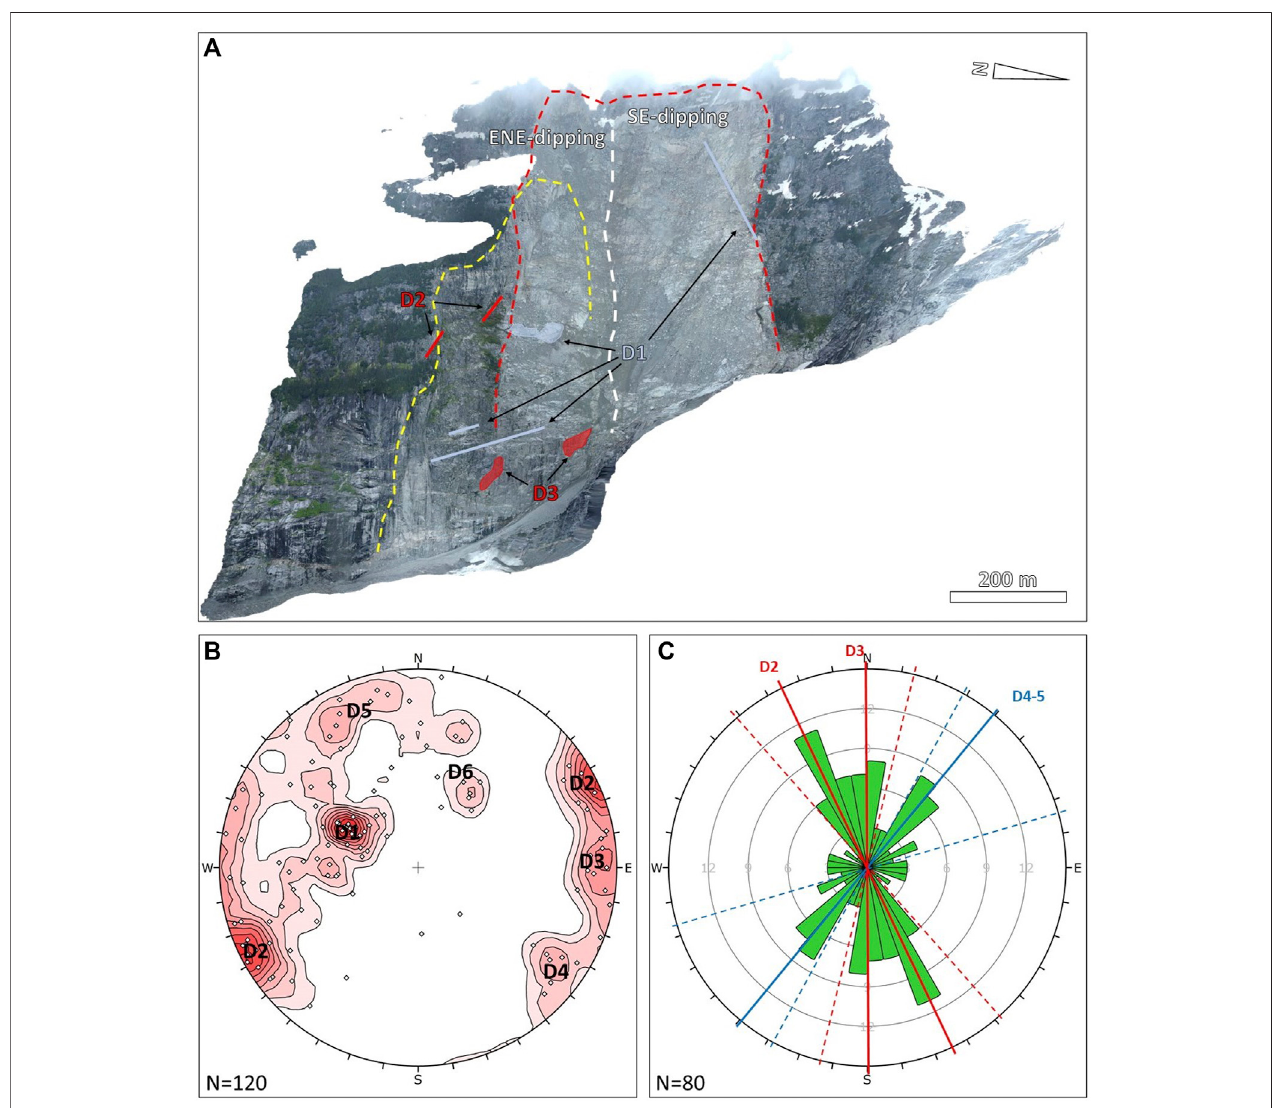
FIGURE 7 | Summary of the rock mass discontinuity mapping results. (A) orthorecti fi ed image of the landslide area, showing sample features of the major discontinuity sets D1-D3. Theyellowand red dashed curves outline theboundaries ofthepre-1950 and the2020 landslides. The whitedashed linemarks thechange in average slope direction (see Figure 3E ) (B) oblique view of the landslide area, showing samples of the major discontinuity sets. (C) lower hemisphere, equal angle stereonet showing the poles of the mapped discontinuities. (C) Rosette diagram displaying the trend of mapped discontinuities with dip angle greater than 60 ° .